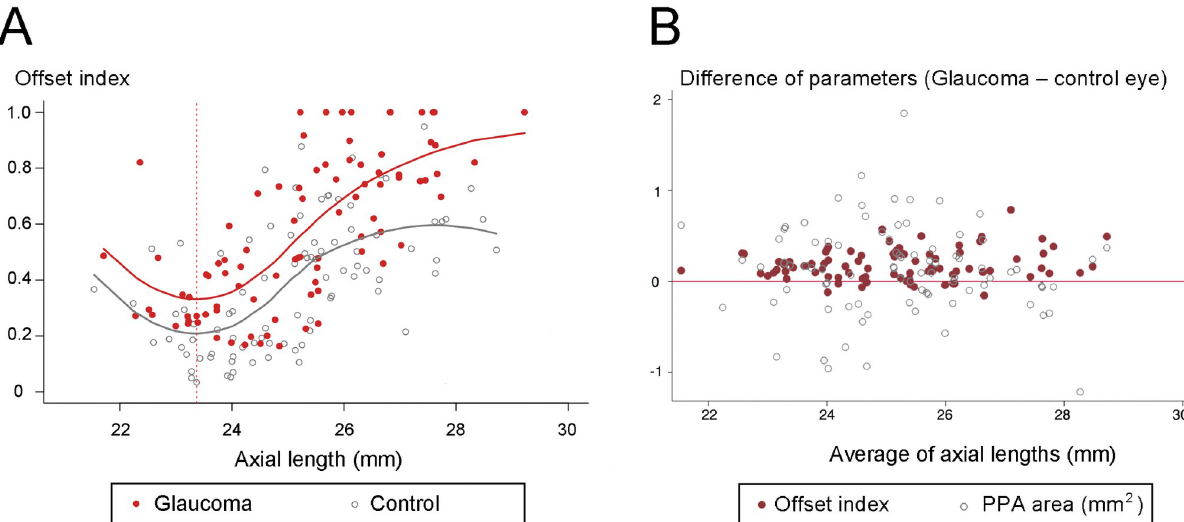
Fig 2. Offset index according to glaucoma diagnosis and axial length. ( A ) Scatter plot showing offset index according to diagnosis and axial length. Locally weighted scatterplot smoothing (LOESS) curves were fitted to describe the change of offset index depending on the axial length in each diagnosis. A generalized estimating equation (GEE) regression model revealed that the offset index was larger in the glaucoma eyes while it showed non-linear relationship with axial length (Table 3). The minimum value of offset index was anticipated at an axial length of 23.4 mm (red dashed vertical line). ( B ) Intra-individual difference of offset index and β -zone parapapillary atrophy (PPA) area. The difference was defined as the subtraction of values in the fellow control eyes from those in the glaucoma eyes. Along the reference line (red line), the upper side represents the larger value in glaucoma eyes, while the lower side the lesser value in glaucoma eyes. Compared with the differences of β -zone PPA areas, those of the offset index were located mostly on the upper side.